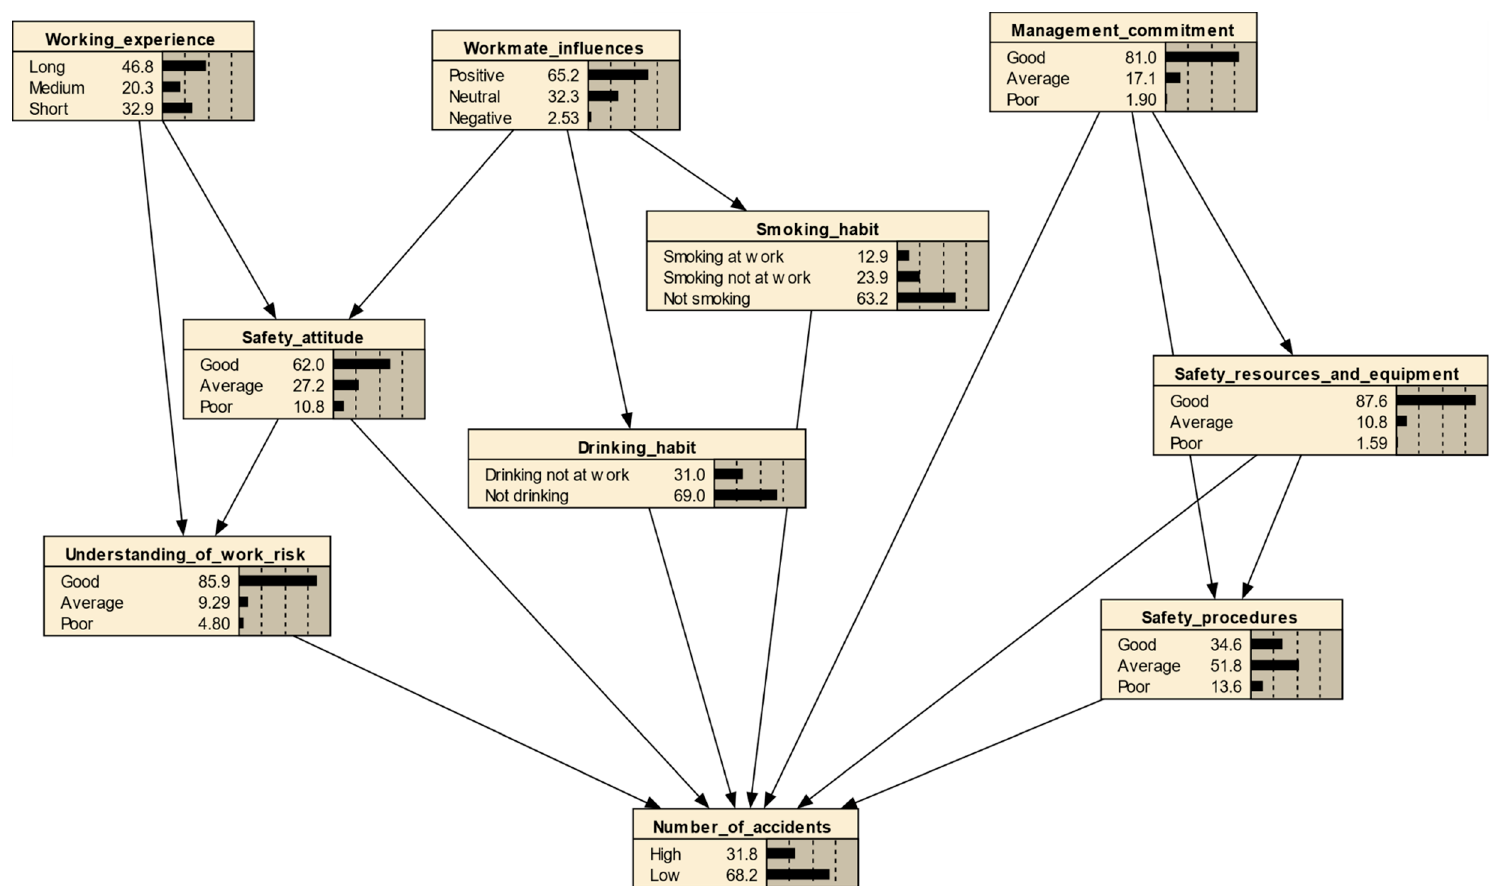
Figure 4. Bayesian network structured to analyze number of E&M work-related accidents.